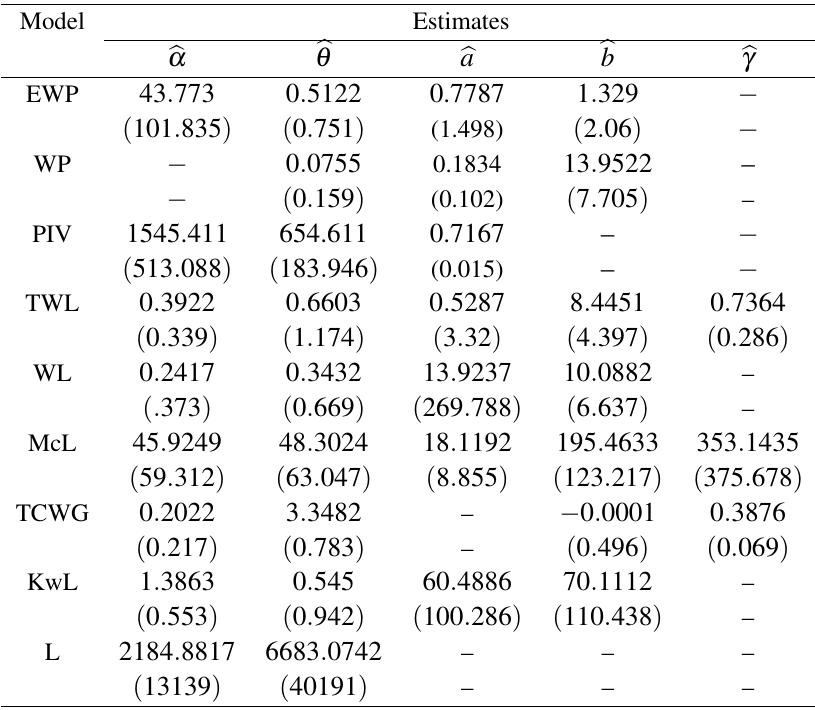
Table 2. MLEs and their standard errors (in parentheses) for carbon fiber data set